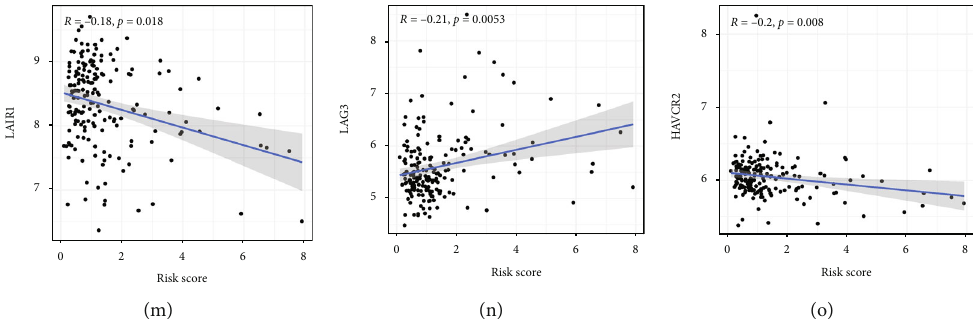
Figure 7: Spearman correlation between risk score and immune checkpoints for tumor-targeted treatment. (a) CTLA-4. (b) VTCN1. (c) TNFSF18. (d) TNFSF15. (e) TNFSF14. (f) TNFRSF25. (g) TNFRSF9. (h) TNFRSF8. (i) TMIGD2. (j) CD276. (k) PDCD1LG2